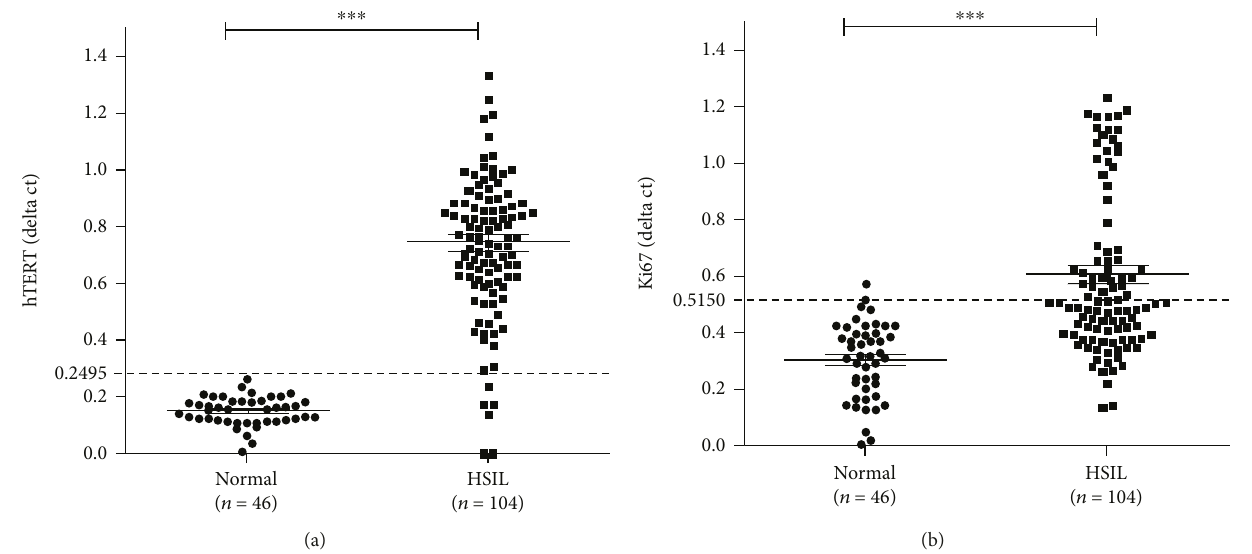
Figure 2: Analysis of the relative expression of hTERT (a) and Ki67 (b) in high-grade squamous intraepithelial lesion (HSIL) versus normal clinical samples using the delta C method. As shown in (a) and (b), normal and HSIL groups were distinguished by hTERT and Ki67 gene t expression showing a statistically signi fi cant di ff erence ( p < 0 001 ), respectively. The cut-o ff value for distinguishing between positive and negative results is determined from the receiver operating characteristic (ROC)